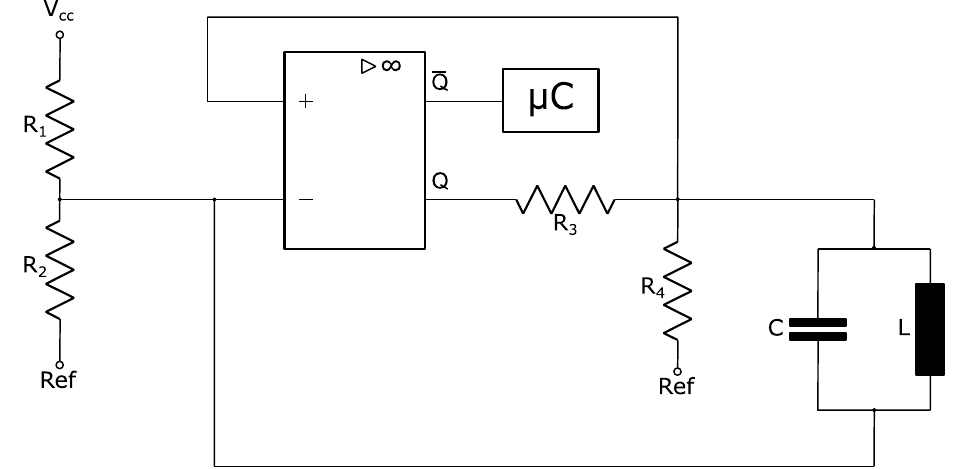
Figure 6. Parallel LC-Circuit with a comparator.